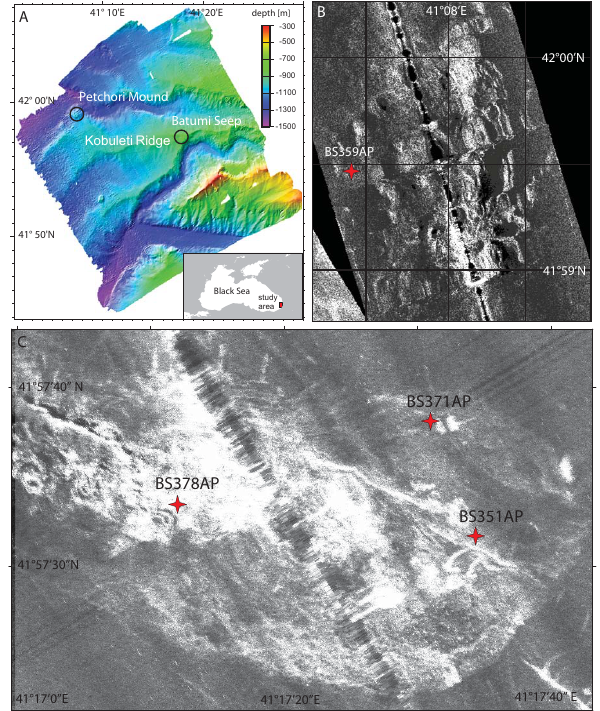
Fig. 1. Working area and coring stations (star symbols and labels) offshore Georgia, eastern Black Sea: (a) detailed bathymetric map of the study area. (b) 30kHz MAK Sidescan sonar mosaic of the Pechori area. (c) Detailed 75kHz DTS-1 sidescan sonar mosaic of the Batumi Seep. The high backscatter intensities in (b) and (c) are shown in light tones and may correlate to the presence of near- surface gas hydrates and authigenic carbonate precipitates (modi- fied after Klaucke et al.,